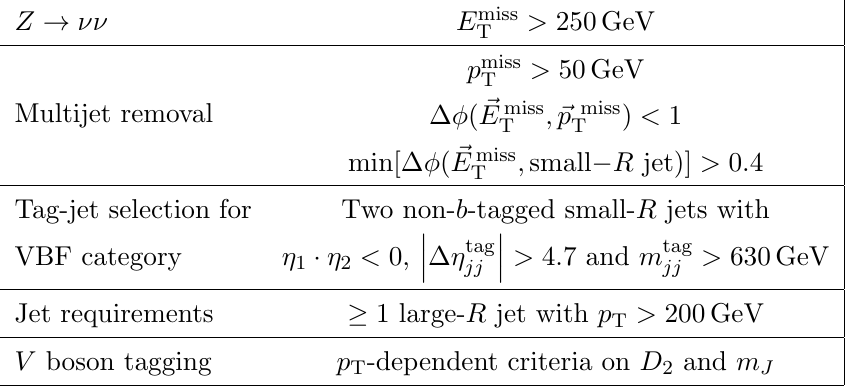
ZV (cid:23)(cid:23)qq selection ! !